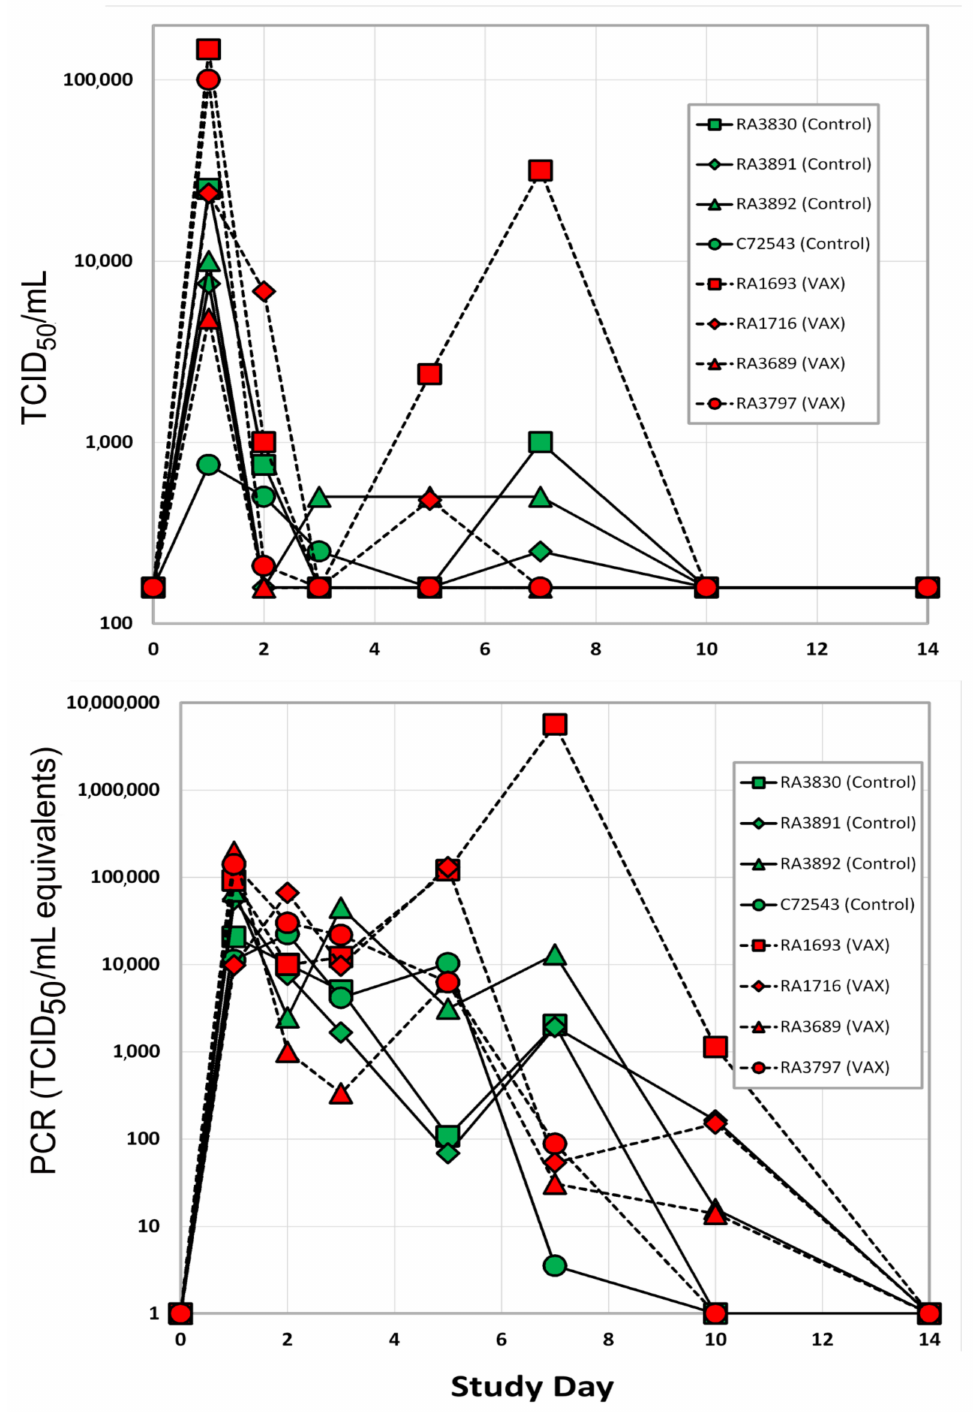
Figure 3. Viral load in nasal swab samples as measured via TCID 50 assay ( top ) and qRT-PCR ( bottom ). The LLOD of the plaque assay was 150 units. Red symbols are vaccinated rhesus macaques, control unvaccinated rhesus subjects are shown in green